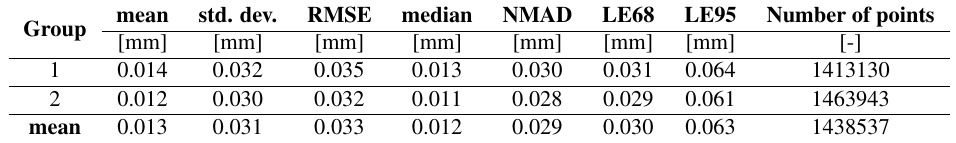
Table 2: Statistical indicators computed for area 2 (border)